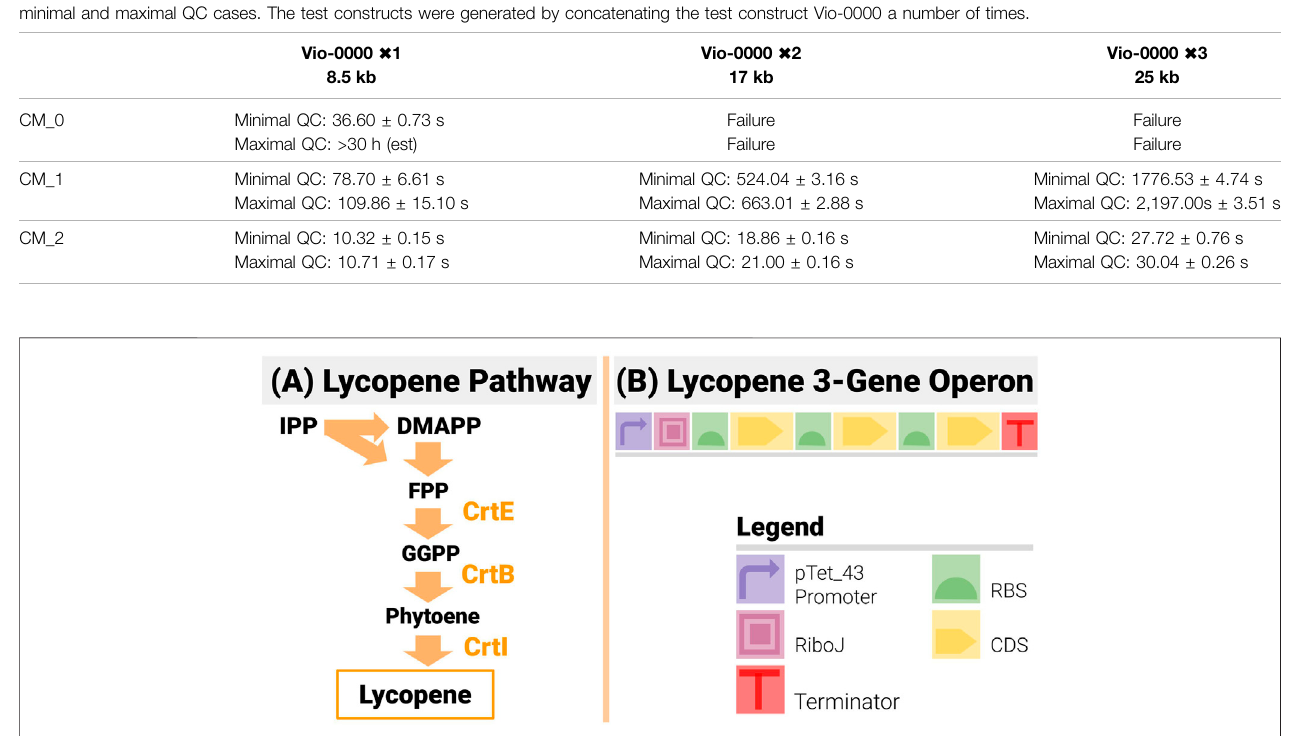
FIGURE 7 | The 3-Gene Lycopene Pathway and its Implementation with an Operon Design. (A) The lycopene pathway is made up of only 3 enzymes (CrtE, CrtB andCrtI)-makingitaverypopulartestbedinmetabolicandcombinatorialpathwayengineering. (B) Thedesignismadeupof3genesinthesetorderCrtE-CrtI-CrtB.An inducible promoter is used to drive the operon and an insulating element RiboJ is inserted post